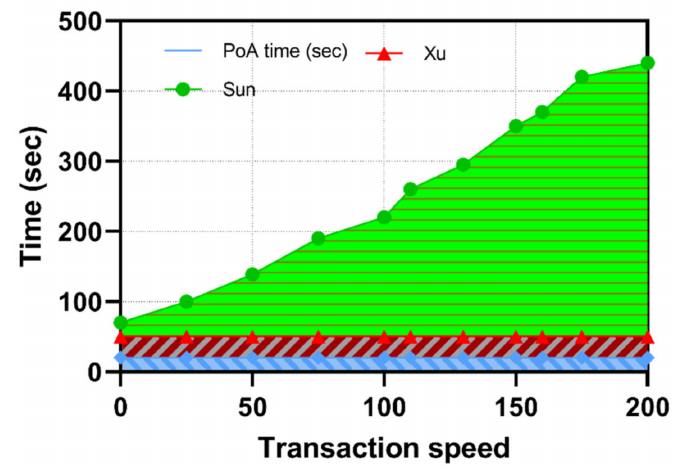
Figure 6. Comparison with existing studies based on block transaction speed.